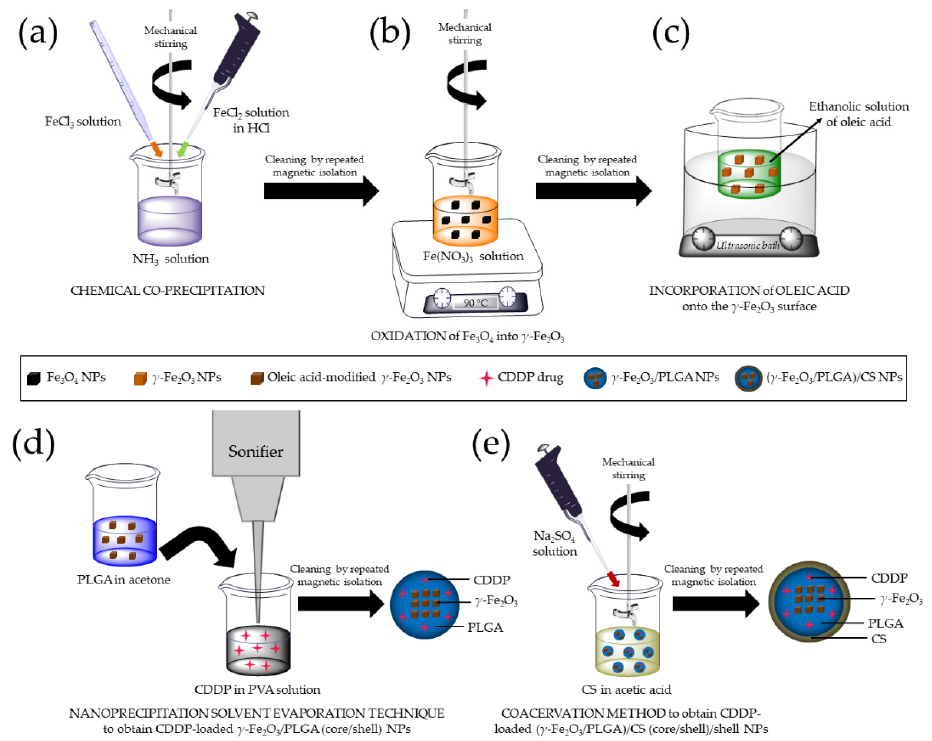
Figure 1. ( a ) Preparation of Fe 3 O 4 NPs by chemical co-precipitation and ( b ) oxidation into γ -Fe 2 O 3 particles; ( c ) surface modification of γ -Fe 2 O 3 NPs with oleic acid; ( d ) formulation of CDDP-loaded γ -Fe 2 O 3 /PLGA (core/shell) particles by nanoprecipitation solvent evaporation; and ( e ) preparation of CDDP-loaded ( γ -Fe 2 O 3 /PLGA)/CS (core/shell)/shell NPs by coacervation.